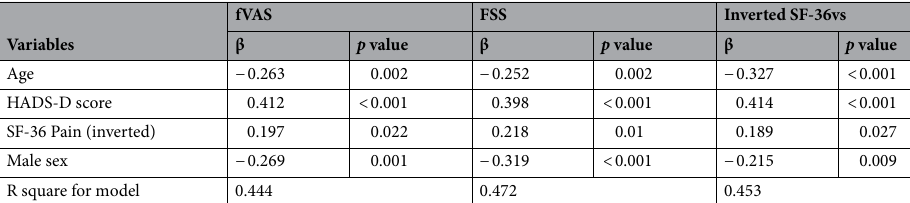
Table 3. Final multiple regression models showing associations between fVAS, FSS, inverted SF-36vs, and selected clinical variables in 90 patients with newly diagnosed celiac disease. FSS Fatigue severity score, fVAS Fatigue visual analog scale, HADS-D Hospital anxiety and depression questionnaire; depression subscale score, Inverted SF-36vs Inverted vitality subscale of the MOS 36-item short-form health survey, SF-36 Pain Pain subscale of the MOS 36-item short form health